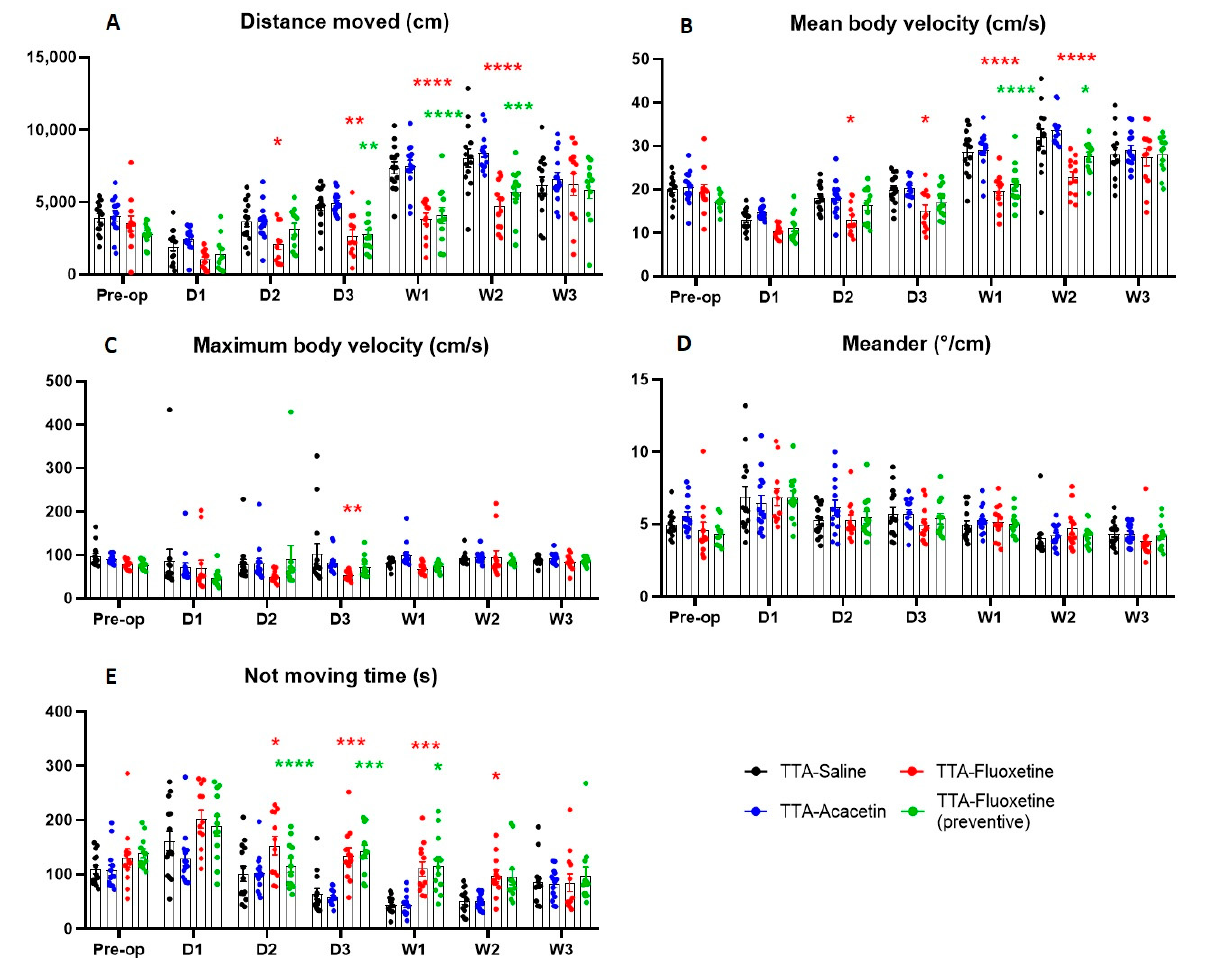
Figure 3. Illustration of the average distance moved ( A ), mean body velocity ( B ), maximum body velocity ( C ), meander ( D ) and not moving time ( E ) automatically measured in a 10 min-session in the open-field. Data represent mean ± SEM; statistically significant differences (* p < 0.05; ** p < 0.01; *** p < 0.001; **** p < 0.0001) compared to the control group, two-way ANOVA applies to all graphs. Significant differences between TTA–Saline and TTA–Acacetin groups, TTA–Saline and TTA–Fluoxetine (preventive) groups and TTA–Saline and TTA–Fluoxetine groups are indicated by blue, green and red stars respectively.